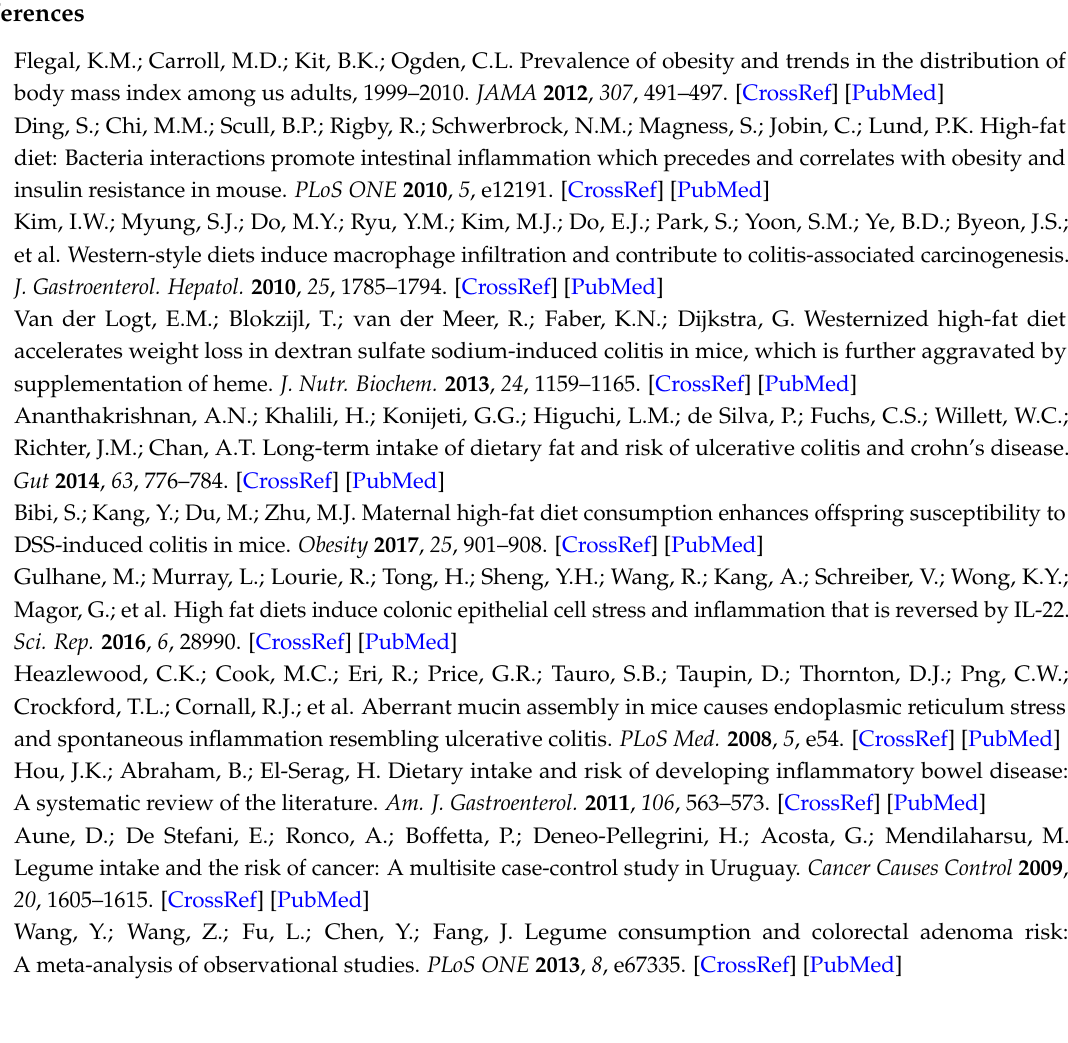
Table S2: Primer sequences for quantitative reverse transcription